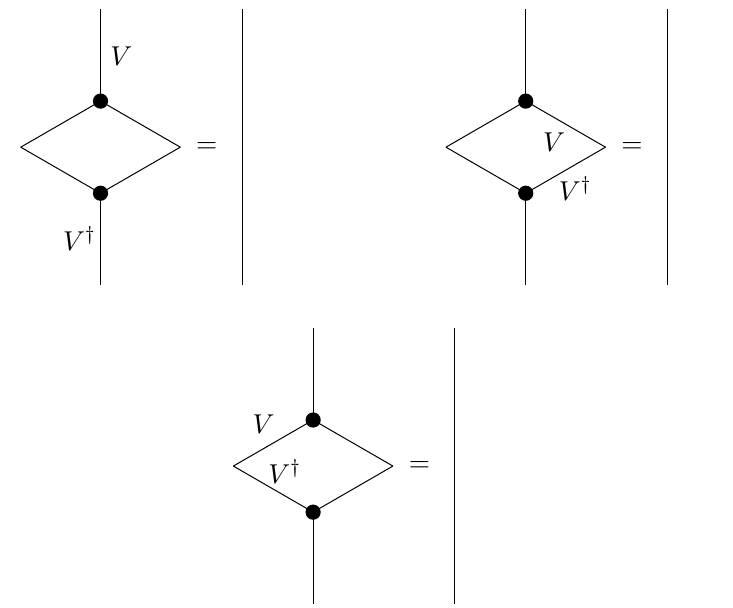
Figure 2 . The conditions for a 3-leg tensor V to be perfect. The straight line represents the